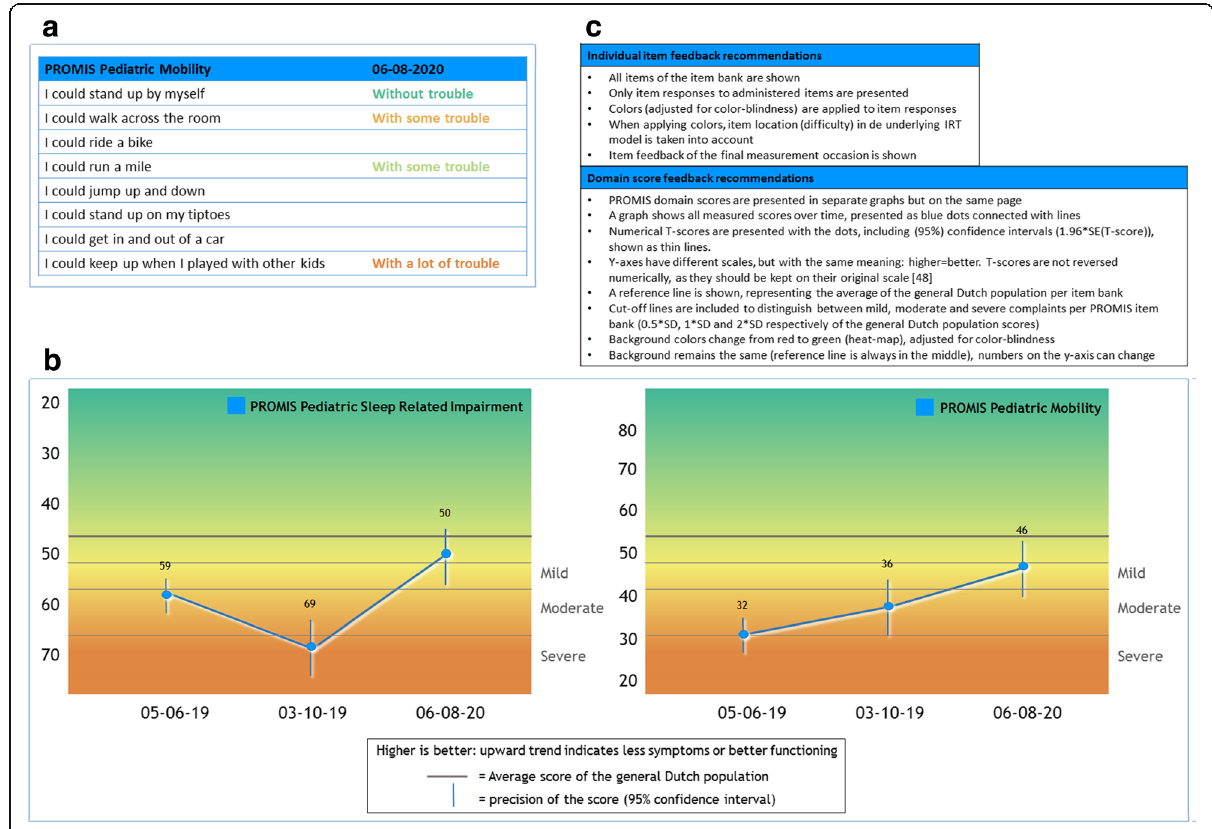
Fig. 5 Final recommended individual item ( 5a ) and domain score ( 5b ) feedback of PROMIS CATs including recommendation boxes ( 5c )